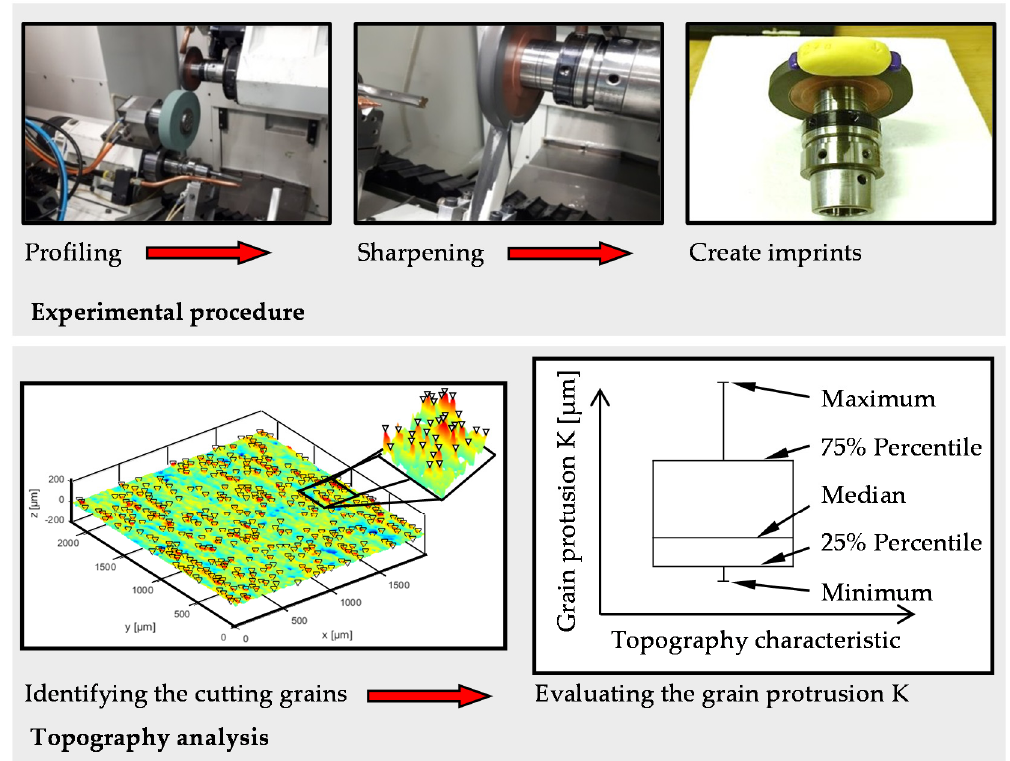
Figure 2. Experimental procedure and topography analysis.